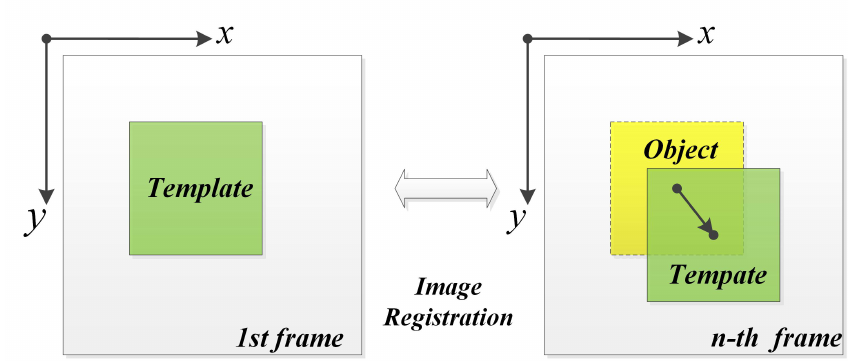
Figure 2. Basic procedure of the